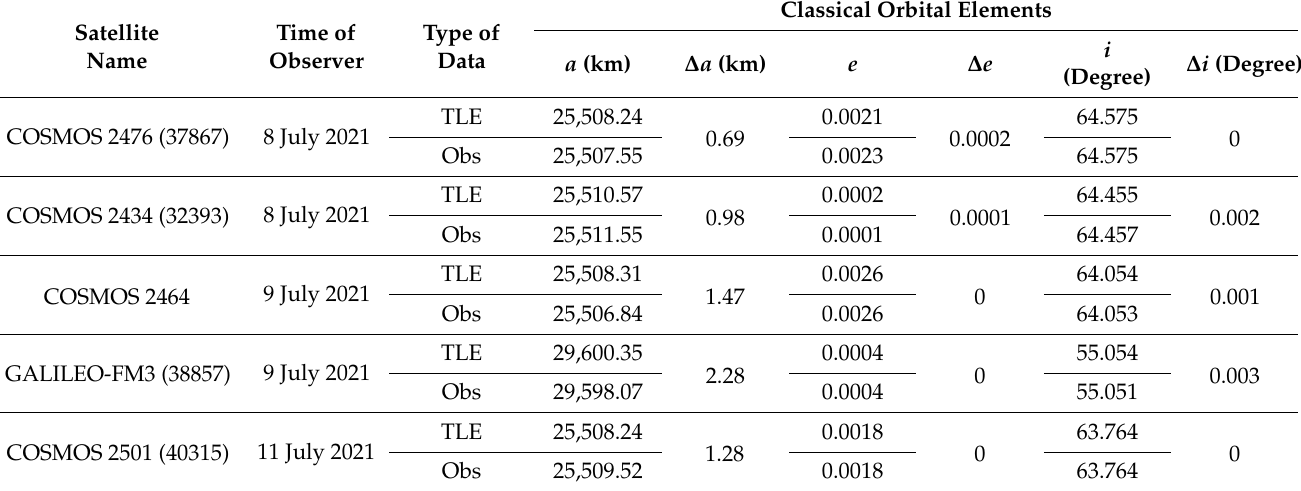
Table 5. Optical observation